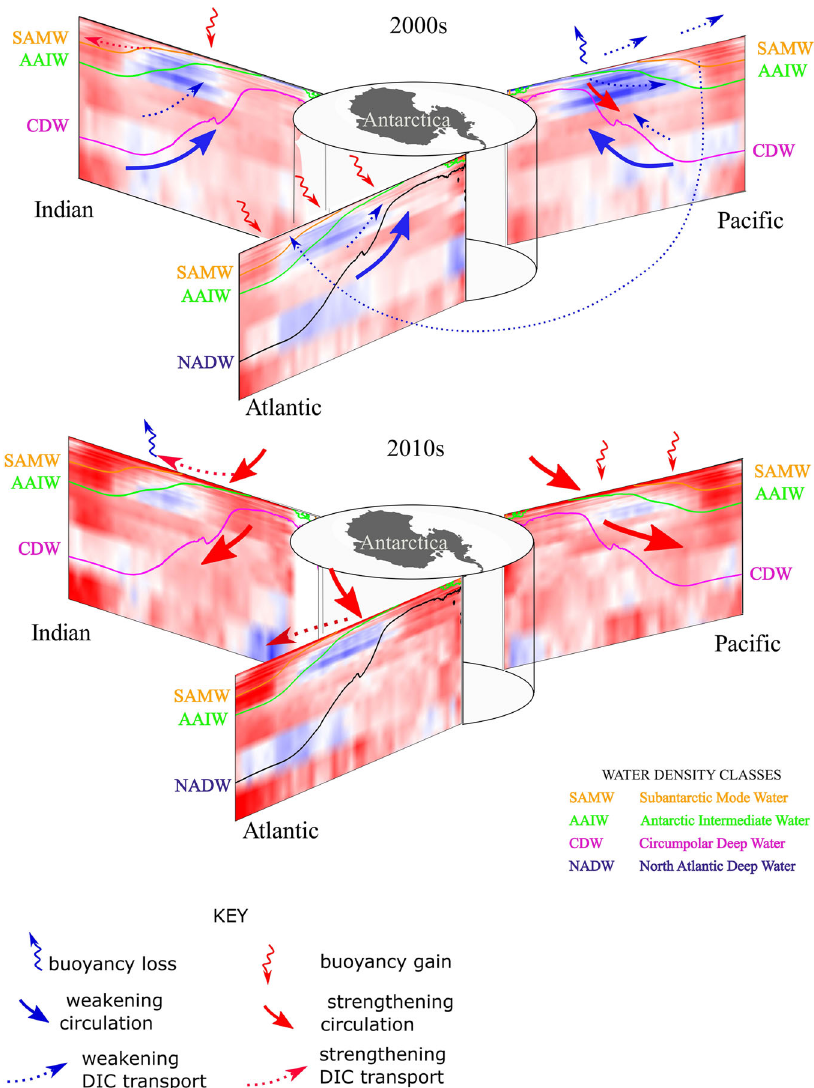
Fig. 4 Schematic of the mechanisms affecting dissolved inorganic carbon (DIC) trends in the 2000s and 2010s between 30 and 75 ∘ S broken down by ocean sectors. Solid colored lines trace out representative density surfaces of each water-mass: Subantarctic Mode Water (SAMW), Antarctic Intermediate Water (AAIW), Circumpolar Deep Water (CDW), North Atlantic Deep Water (NADW). Blue (red) color shading indicates decreasing (increasing) DIC trends. Curly arrows mark buoyancy forcing at the surface: blue (red) indicating buoyancy loss, i.e., input of denser water (buoyancy gain, i.e., input of lighter water). Solid thick arrows mark changes in ocean circulation: blue (red) indicating weakening (strengthening) fl ow in the indicated direction. Small dotted arrows mark relative strength of DIC transport: blue (red) indicating weakening (strengthening) transport or transport of lower (higher) DIC concentrations. Map of Antarctica was made with Natural Earth. Free vector and raster map data ( naturalearthdata.com ) using Cartopy 77